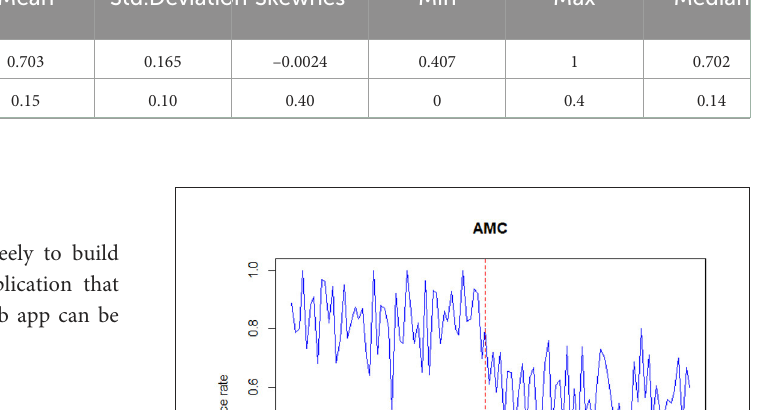
TABLE 2 Descriptive statistics for the data on rate of E. coli resistant to AMC and CSL. Antibiotic